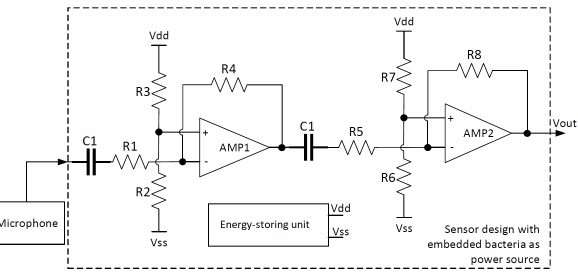
Figure 12. Sensor circuit design with embedded two MFC units to provide 2.4